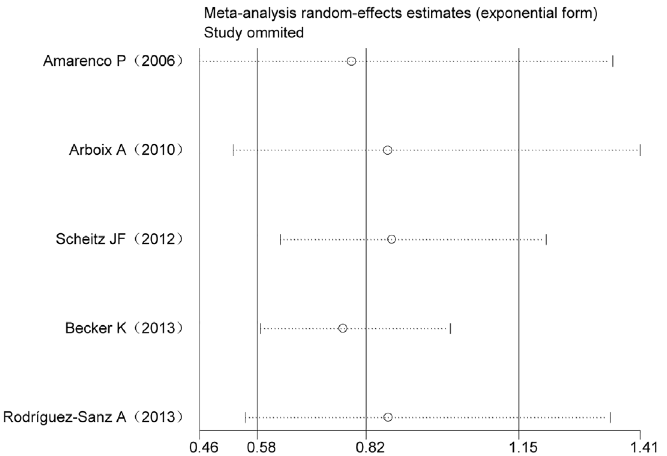
Fig 3. Sensitivity analyses for the five included studies (Each small circle indicates mean differences. The intervals between the two short lines around each circle indicate the 95% CI of each study).